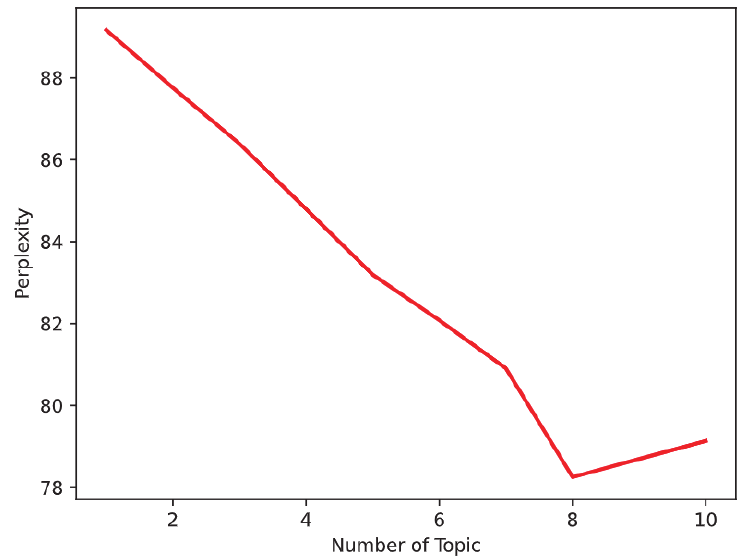
Figure 2. Topic Puzzlement of LDA Model. Table 1. Extraction Results of Road Traffic Accident Themes.